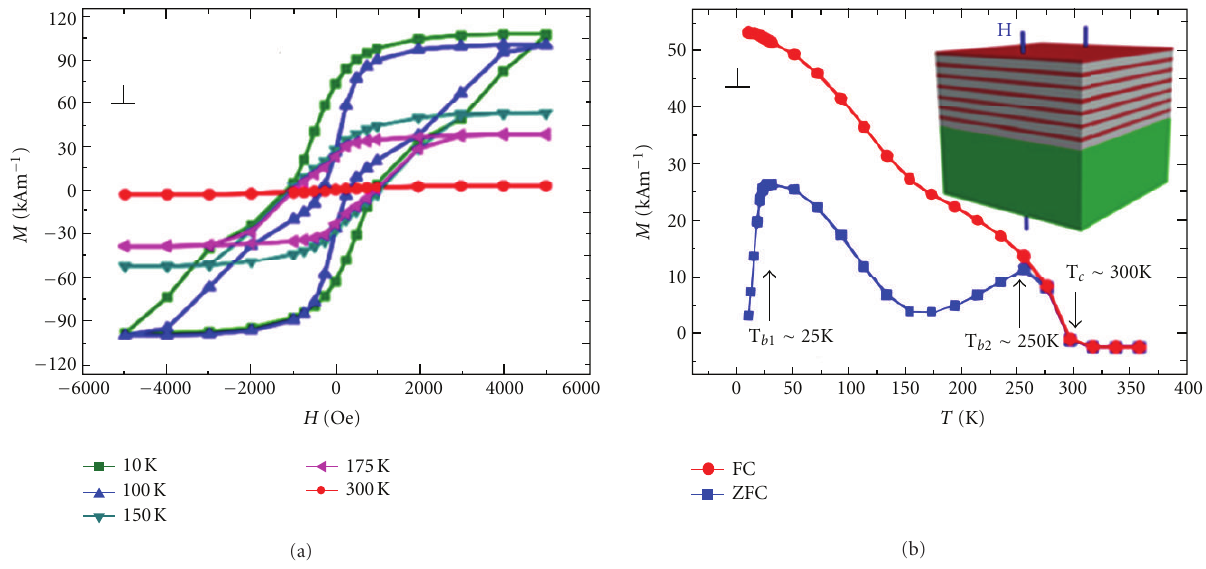
Figure 18: Magnetic properties of the MnGe nanowells. (a) Temperature-dependent hysteresis loops at 10, 100, 150, 175, and 300 K, with the sample surface perpendicular to the external magnetic field. (b) ZFC and FC curves under a magnetic field of 200 Oe, and the sample setup during the SQUID measurements (inset). Reproduced from [21]. Copyright ©2010 IOP Publishing Ltd.